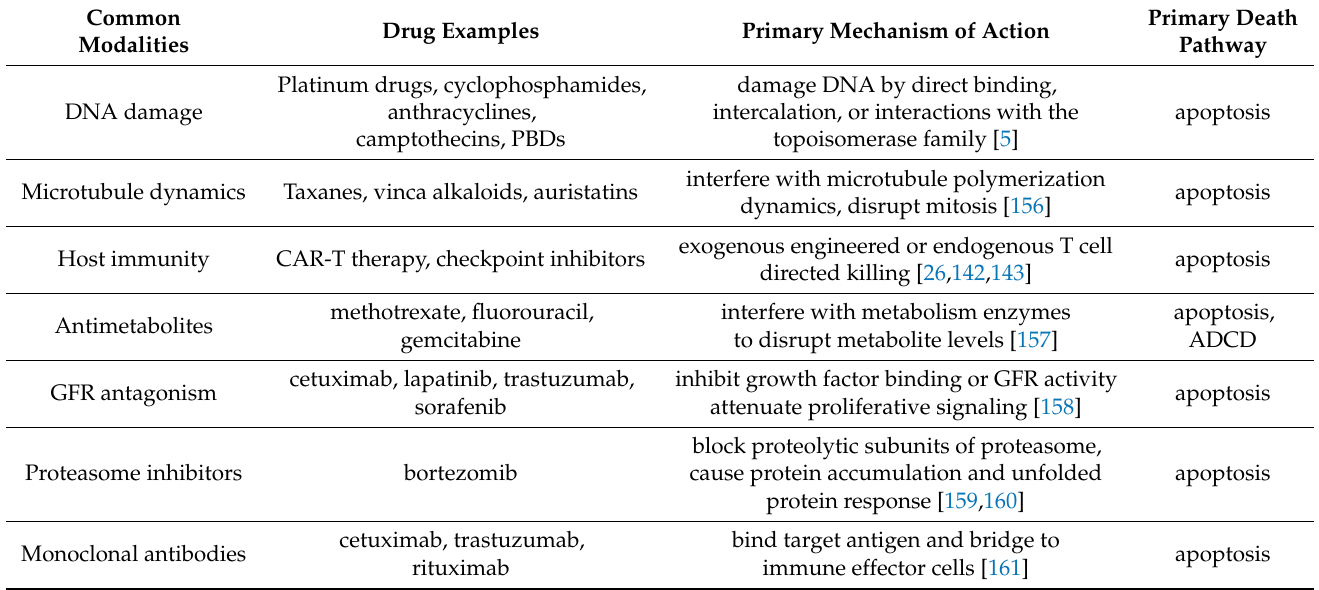
Table 3. Cancer therapeutics and cell